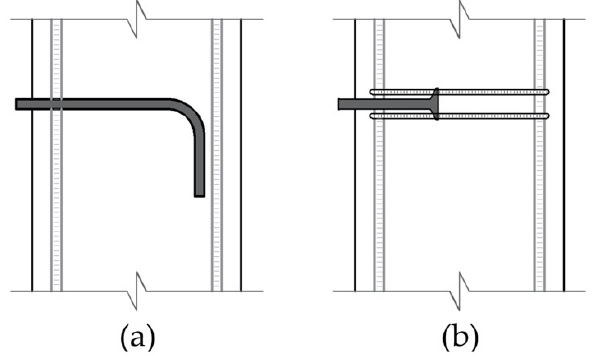
Figure 2. Different types of anchoring the beam reinforcement in the columns: ( a ) traditional anchorage via hooked rebar; ( b ) headed anchor (headed bar) with supplementary reinforcement.